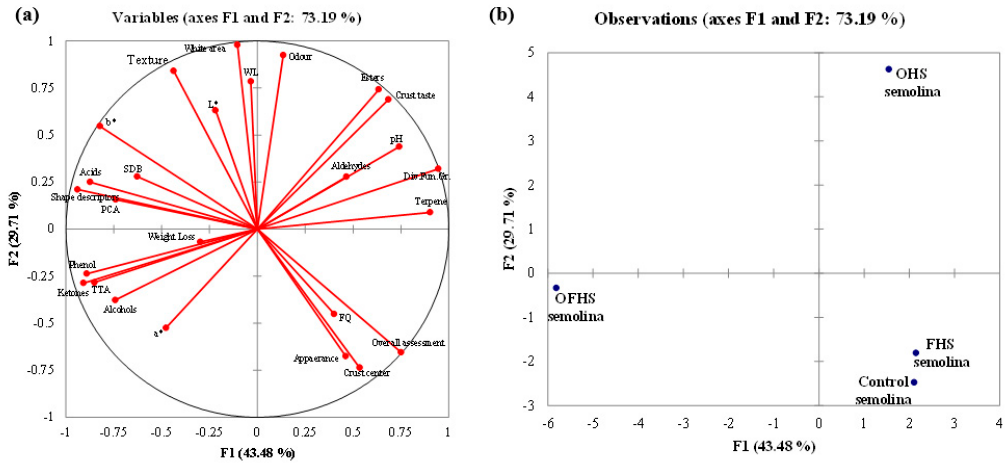
Figure 7. Loading plot ( a ) and score plot ( b ) resulting from principal component analysis on 26 variable groups determined on fermented pizza doughs, baked unseasoned pizzas, and final